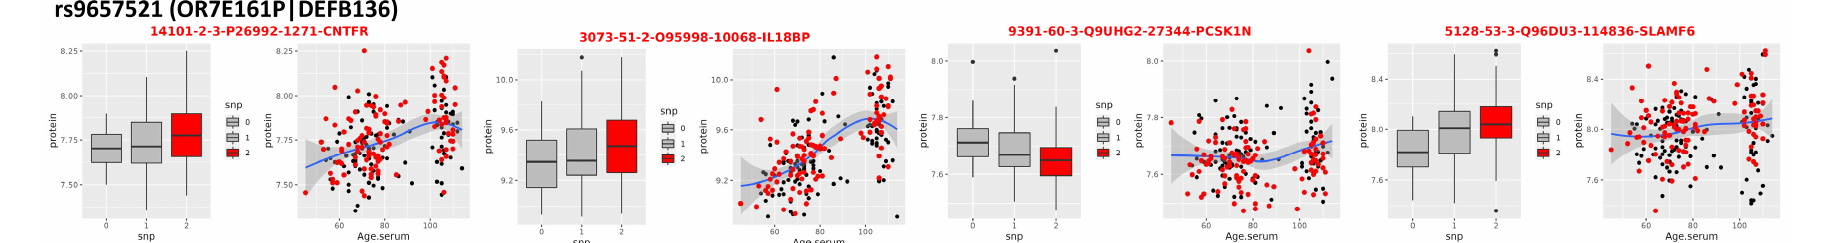
Figure 4. pQTLs in OR7E161P | DEFB136 . Proteins that correlate with genotypes of the SNP rs9657521, which was associated with extreme human longevity in the discovery GWAS. For each protein: the boxplots on the left show the distribution of the log-transformed protein data by genotype group (red = homozygote genotype for the longevity allele; gray/black = genotypes of carriers of one or two non-longevity alleles); the scatter plot on the right shows the distribution of the log-transformed protein data ( y -axis) versus the ages of study participants ( x -axis).